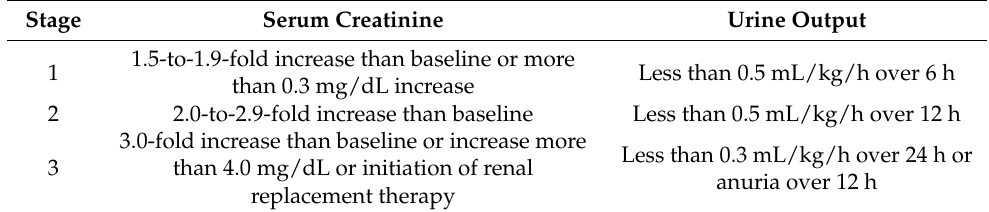
Figure 1. Schematic diagram of patient enrollment. Table 1. Grading of AKI severity according to KDIGO criteria based on Kellum et al. [12].